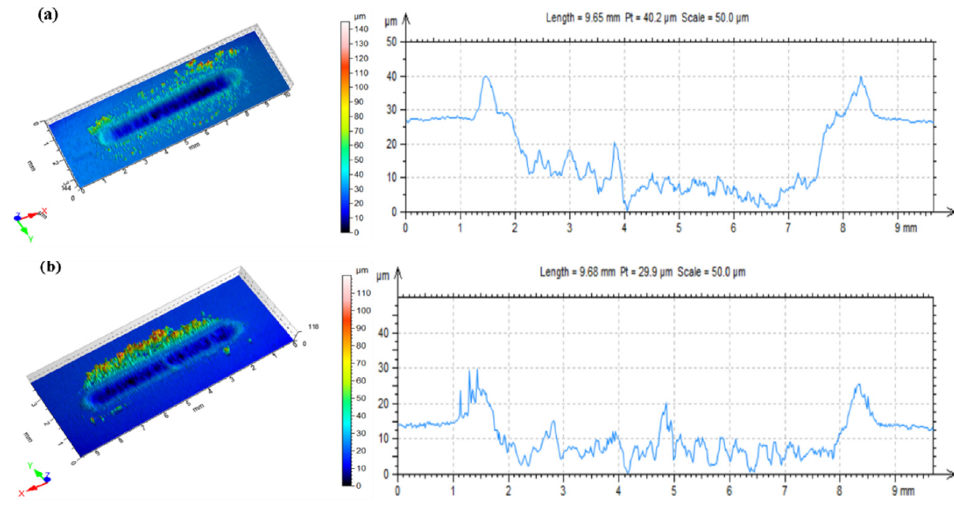
Figure 8. Three-dimensional contour map of wear track of S0 ( a ) and S5 ( b ) at 60 N.